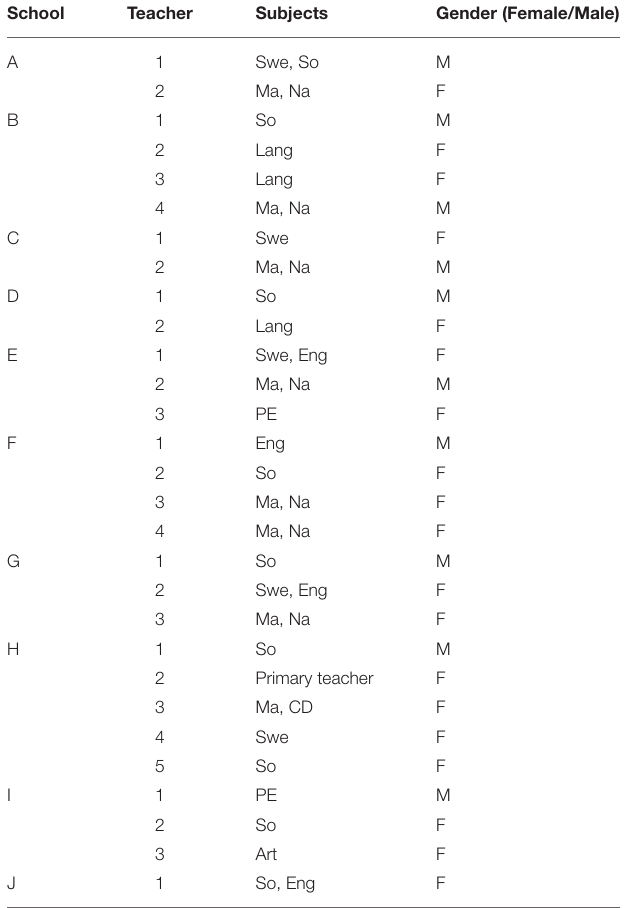
TABLE 3 | List of all teachers in relation to school and